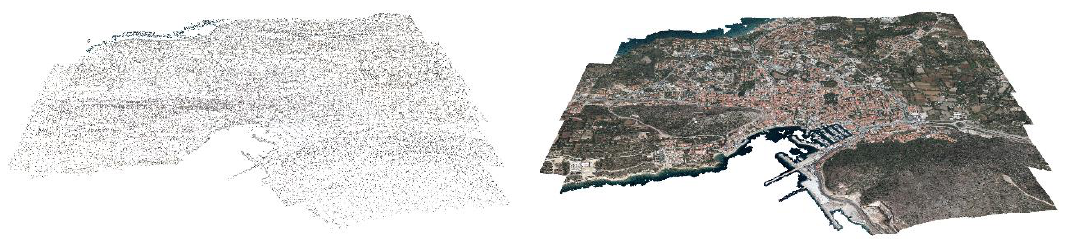
Figure 10. Generated tie points ( left ) and dense point cloud ( right ) using Agisoft Photoscan.